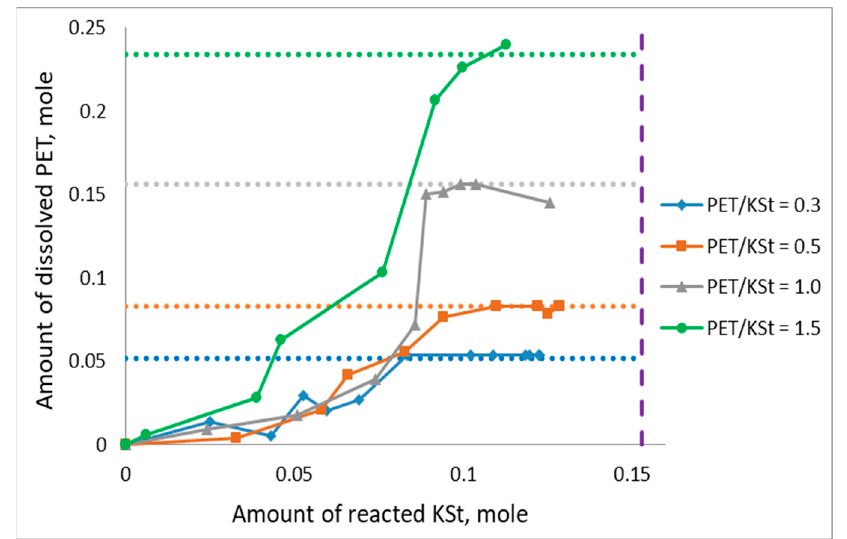
Figure 6. For different initial molar ratios of PET/KSt at 190 °C, there is a correlation between the decreasing amount of determined potassium ions (as potassium stearate equivalents) and the amount of dissolved PET. An initial amount of KSt—0.156 mole. Horizontal lines are total amounts of PET; vertical lines are total amounts of